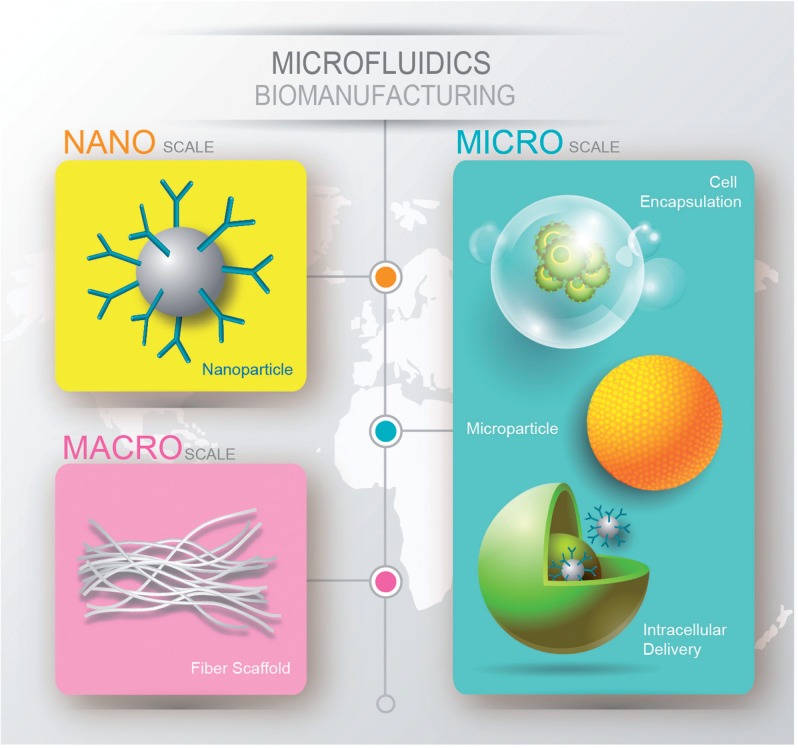
Illustration of nano- to macro-scale products manufactured with microfluidics